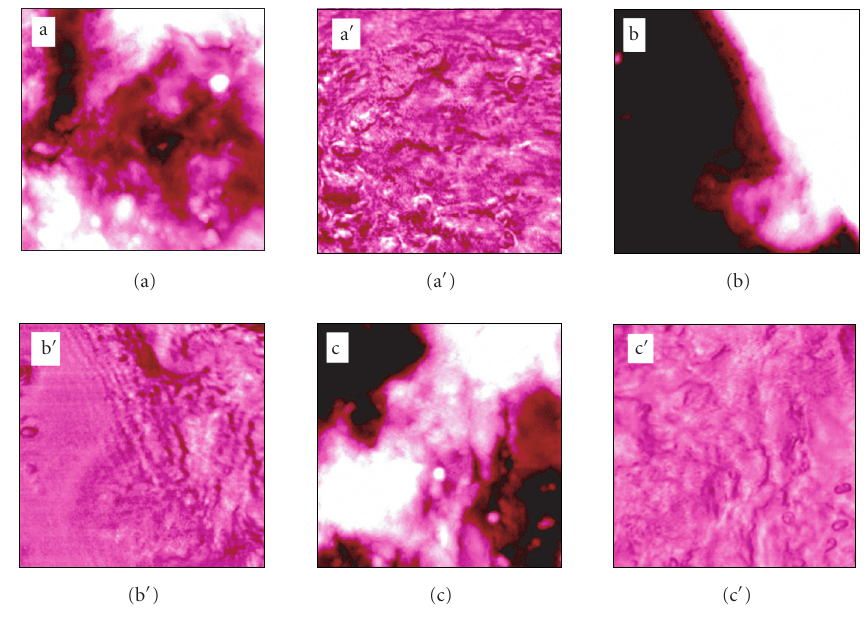
Figure 28: Shear-force AFM topographies (25 μ m, Z range 1 μ m) at three di ff erent sites (a), (b), (c) and the corresponding optical contrast (a (cid:3) ), (b (cid:3) ), (c (cid:3) ) of apertureless SNOM on the rough surfaces of healthy bladder tissue.